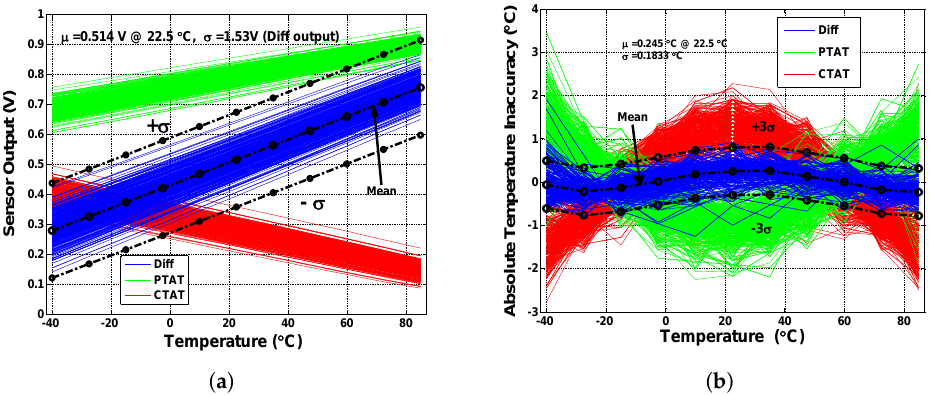
Figure 6. Post layout Monte Carlo simulation results of: ( a ) sensor outputs; and ( b ) absolute temperature